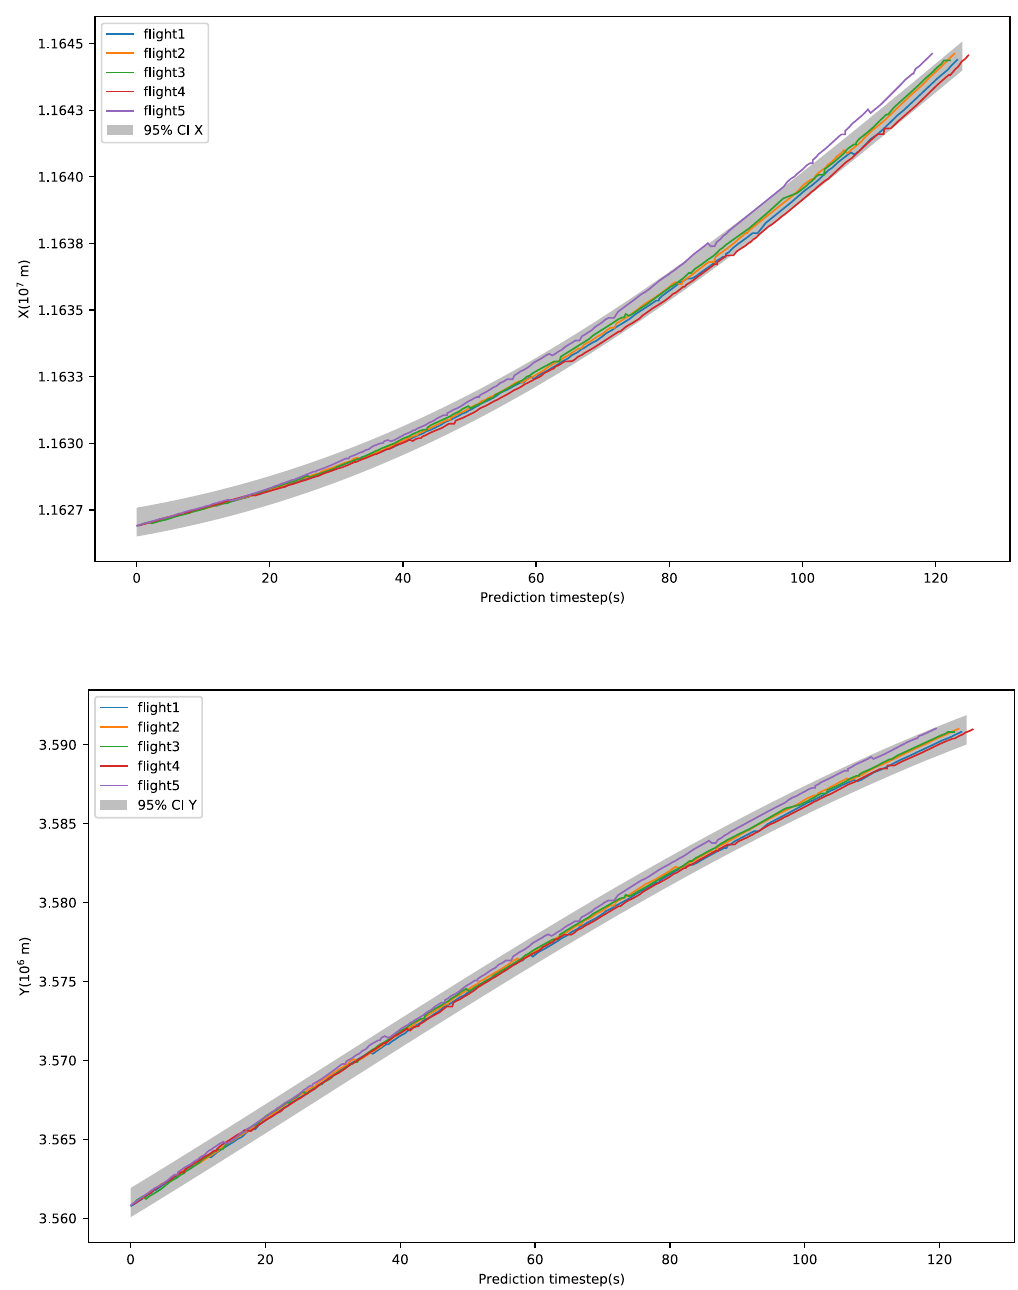
Figure 11. CIs (95%) of the predicted trajectory for flight turn (up: X dimension; down: Y dimension).